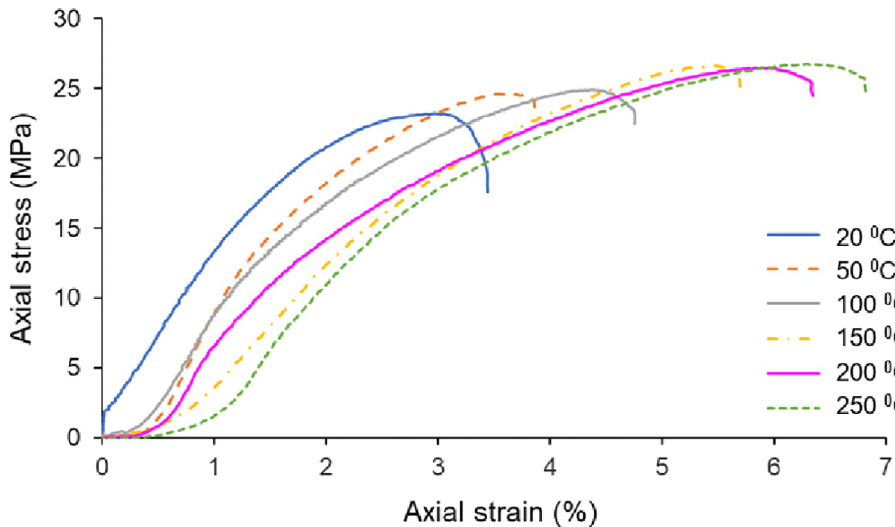
Fig 8. Axial stress and axial strain relationships for various